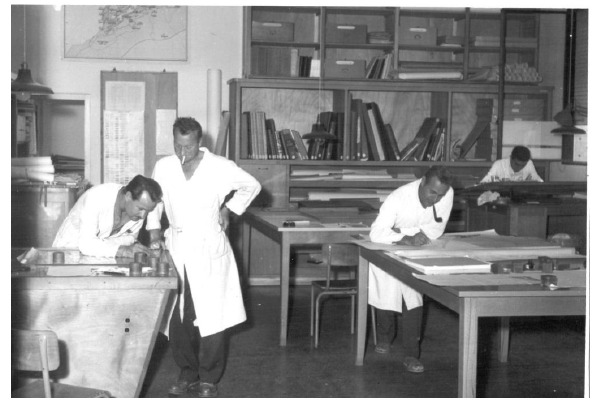
Figure 7 Figure 7. The Laboratory of Physical Geography team at work in 1961. Courtesy of Mrs Dura ff our (CNRS,